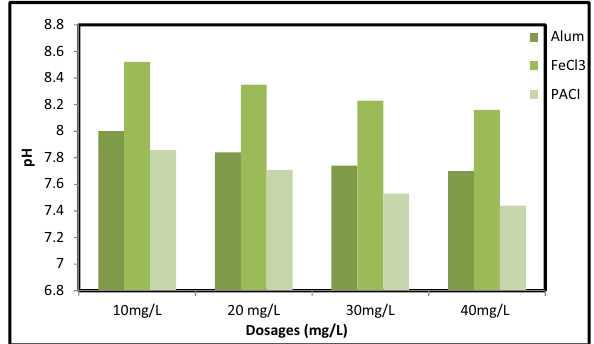
Figure 7: The relation between pH and dosages of coagulants for samples at 300 cm